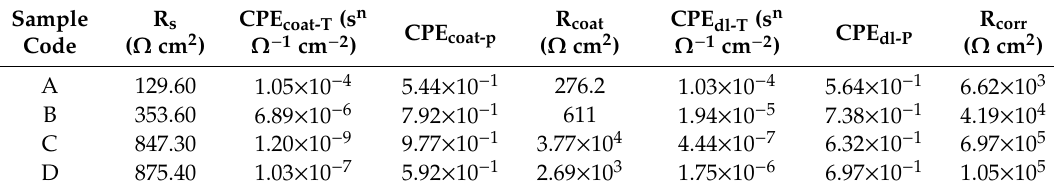
Figure 10. Employed electrical equivalent circuit for the fitting of the Nyquist and bode curves. Table 3. Electrochemical impedance spectroscopy (EIS) parameters for the scratched coatings and immersed in the 3.5 wt.% NaCl.